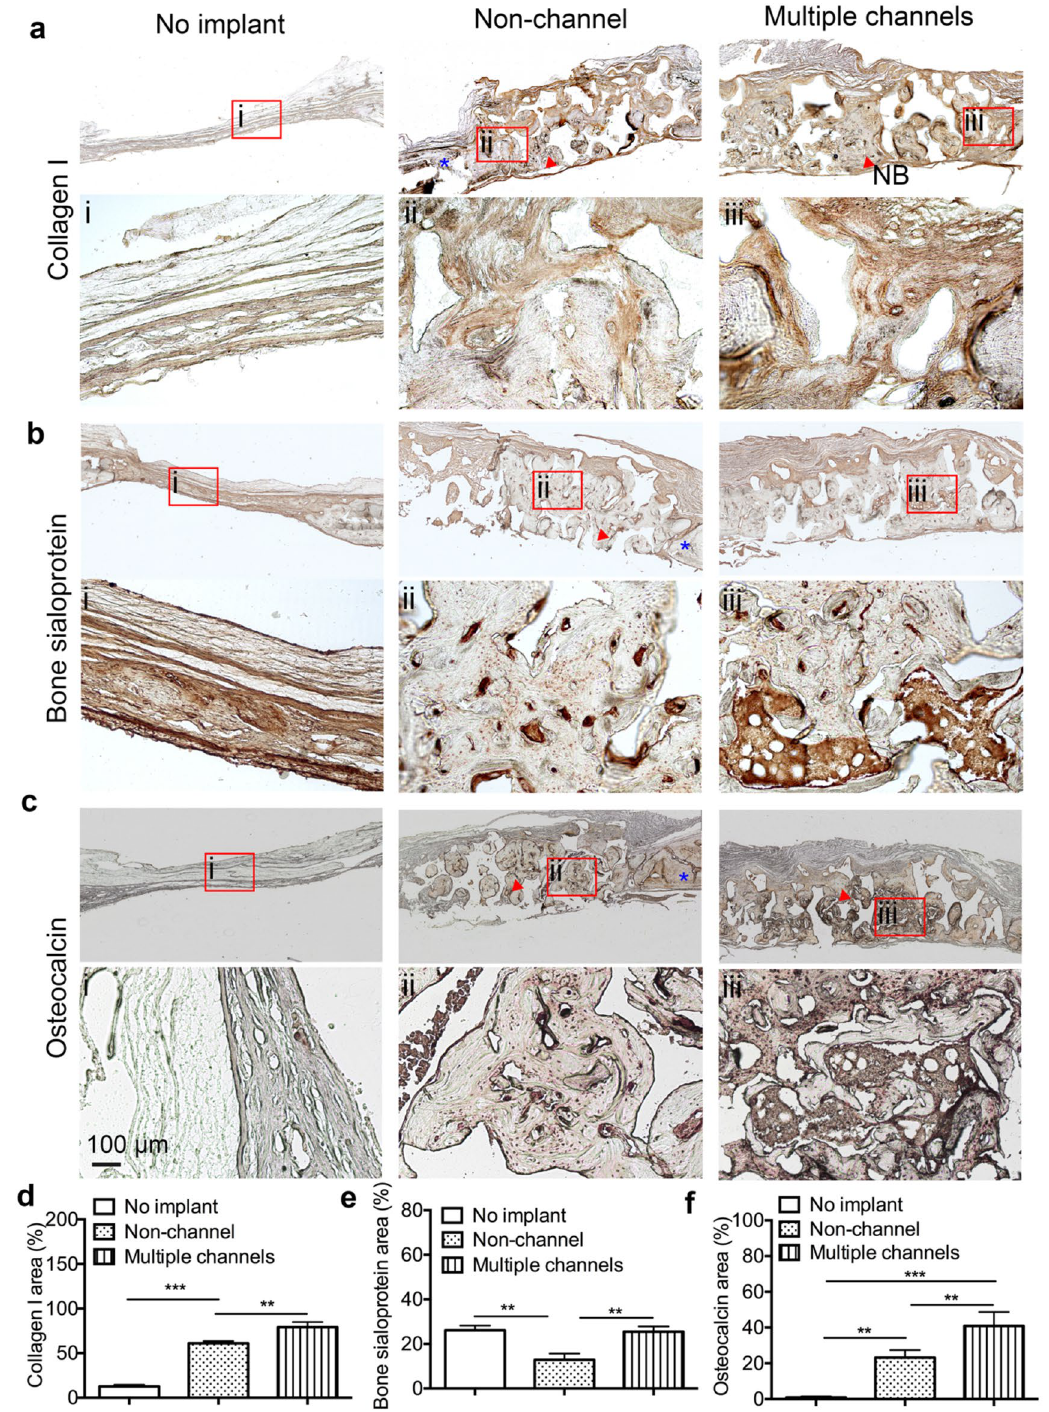
Figure 8. Immunohistochemical staining: the immunohistochemical staining of collagen type I ( a ), bone sialoprotein ( b ), and osteocalcin ( c ), and their respective quantitative results from the images of collagen type I ( d ), bone sialoprotein ( e ), and osteocalcin ( f ). Magnified images from a local spot of the three groups: (i) no implant, (ii) non-channel, and (iii) multiple channels. Red arrows mean new formed bone tissue matrix, and blue * means native bone matrix. These result show that channeled scaffolds significantly promoted the formation of more bone matrix than non-channeled scaffolds and no-implant groups. (n = 3, * p < 0.05, ** p < 0.01, *** p <